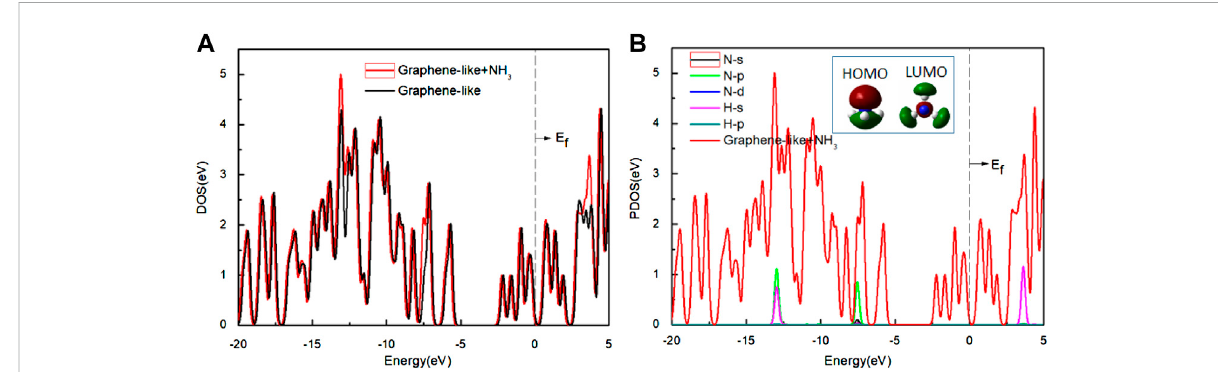
FIGURE 6 (A) TheDOSofthegraphene-likesurfacebeforeandafter adsorption ofNH 3 ; (B) ThePDOSoftheNH 3 onthesurface.Inset:HOMOandLUMO of NH 3 (green and deep red lines indicate different signs of the orbital wavefunctions). Main panel: The red line is the DOS of NH 3 on the graphene- like surface, and other lines show the PDOS of the H and N atoms,